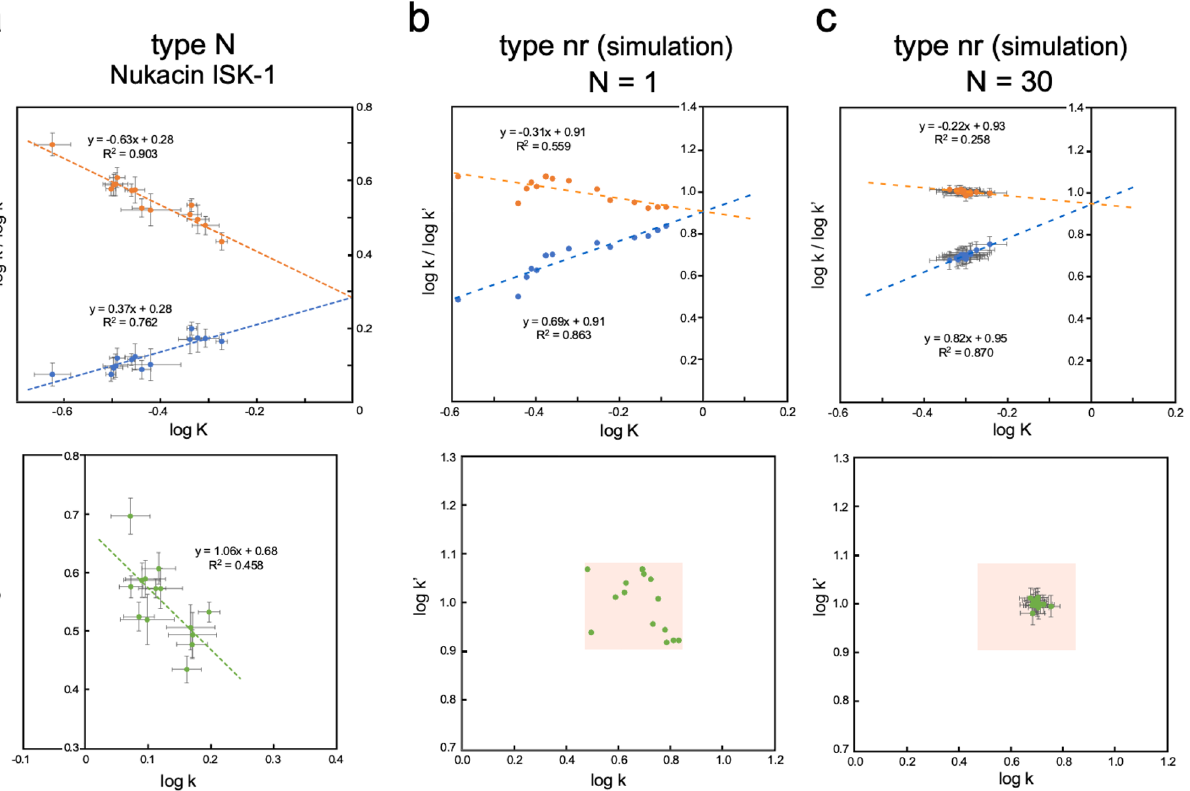
Figure 4. Risk evaluation of linearity overestimation in the REFER plots. ( a ) REFER plot and log k vs. log k ′ plot of nukacin ISK-1 15 as a reference. The error bars represent one standard error. ( b ) REFER plot and log k vs. log k ′ plot artificially generated using a synthetic dataset. Assuming a 15-residue protein, 15 k and k ′ values are generated as uniformly distributed random numbers between 3 and 7 and between 8 and 12, respectively. The numerical ranges used are shown as the rectangular shape in the log k vs. log k ′ plot. ( c ) The random number generation per residue was repeated 30 times (N = 30). The error bars represent one standard error of the mean. Note that one standard deviation is 5.5 (the square root of 30) times larger than one standard error of the mean.